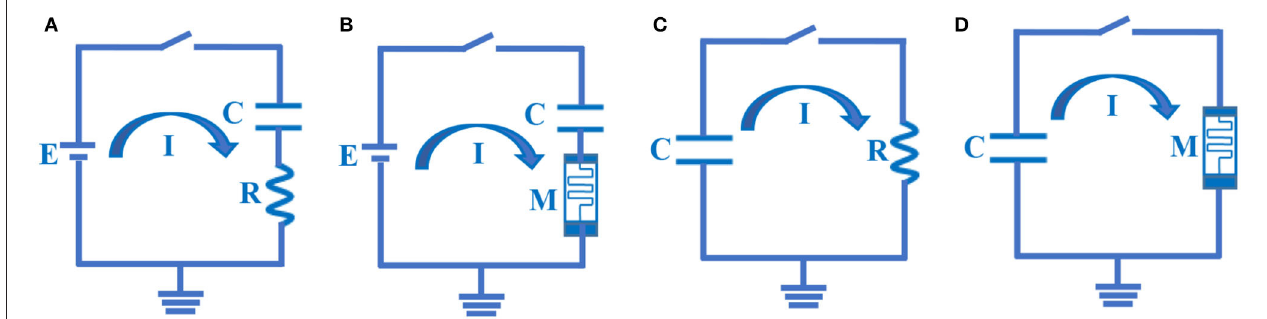
FIGURE 2 | The RC and MC charging – discharging circuits. (A) The RC charging circuit. (B) The MC charging circuit. (C) The RC discharging circuit. (D) The MC discharging circuit.